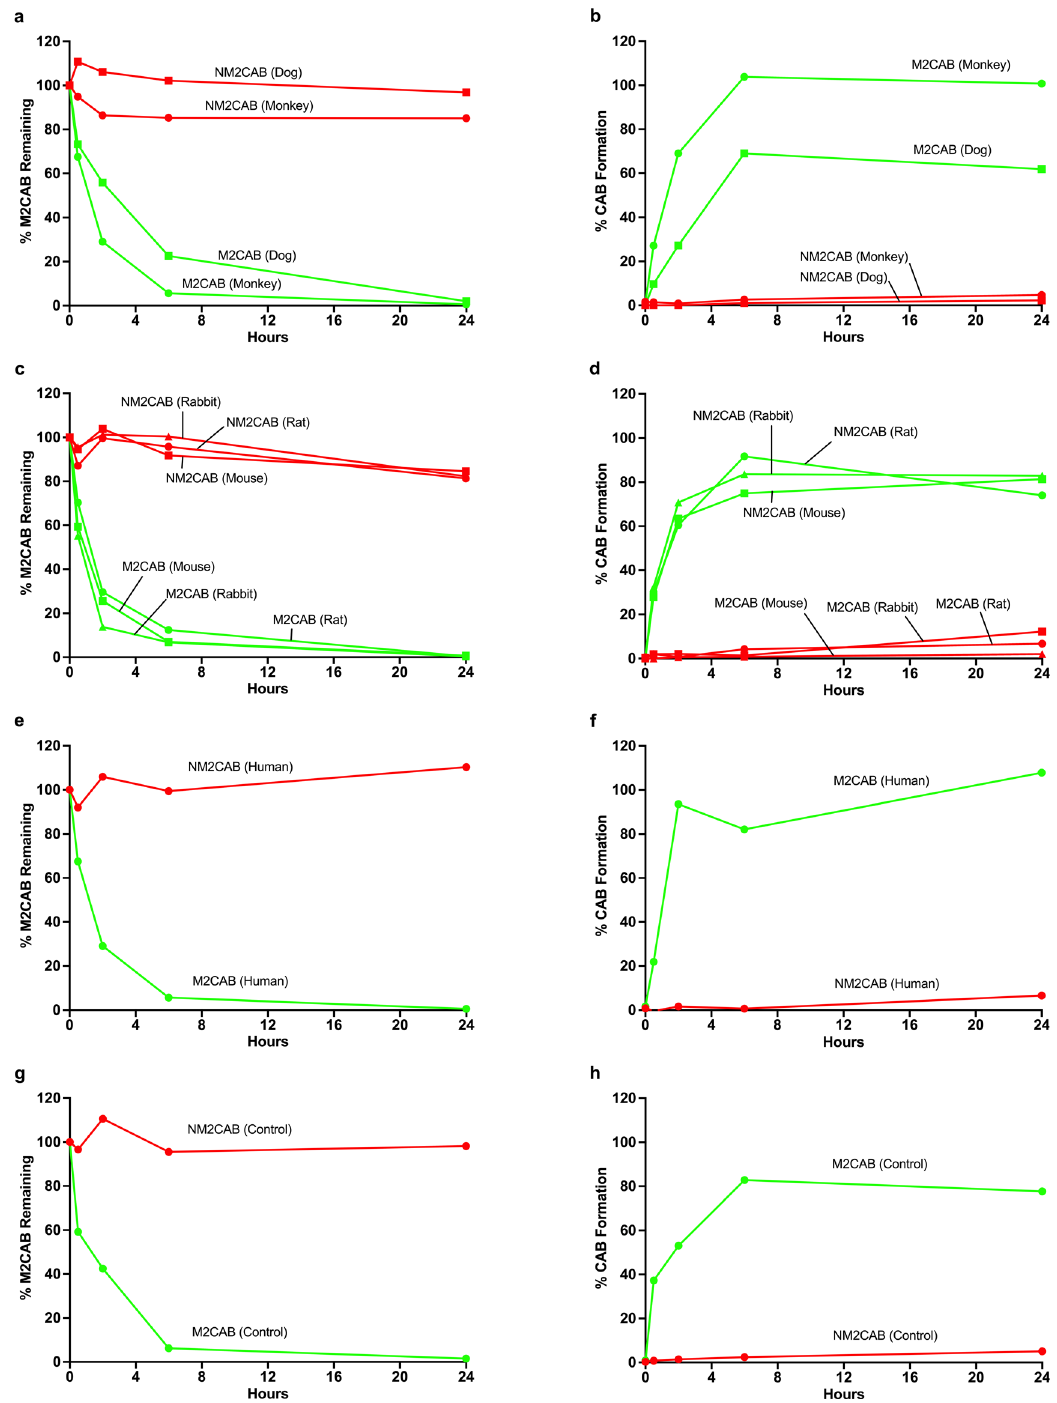
Fig. 3 Blood metabolic stability pro fi les of prodrug (M2CAB) and nanoformulated prodrug (NM2CAB). Stability pro fi les of prodrug (M2CAB) and nanoformulated prodrug (NM2CAB) at 1 µ M concentration and formed native drug concentrations were determined in blood from six mammalian species (mouse, rat, rabbit, monkey, dog, and human) and in heat-inactivated plasma as a control. Data shown as disappearance for M2CAB over time (alone and from NM2CAB nanoformulations) in ( a ) monkey and dog, ( c ) mouse, rat and rabbit, ( e ) human, and ( g ) heat-inactivated plasma (control). Parallel measurements of CAB appearance over time were also recorded from M2CAB and NM2CAB in ( b ) monkey and dog, ( d ) mouse, rat and rabbit, ( f ) human, and ( h ) heat-inactivated plasma. Data are expressed as mean ( N = 2 biological replicated per time point). Each experiment was repeated independently two times with equivalent exception of the brain in both mice and rats. The highest CAB ex vivo hydrolysis of prodrug or parent drug formation during sample preparation, storage, and analysis. lymph nodes, followed by the spleen, lung, kidney, and liver (Table 3). M2CAB concentrations in many tissues were higher Tissue CAB distribution . After both NM2CAB and NCAB than that of CAB at all time points. At day 28, CAB tissue treatment, CAB was widely distributed to all tissues with the